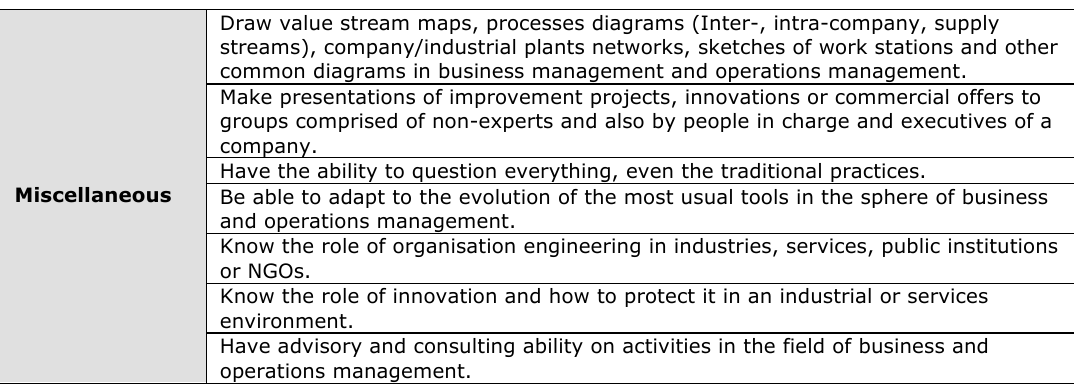
Table 2e. “Specific competences of Industrial